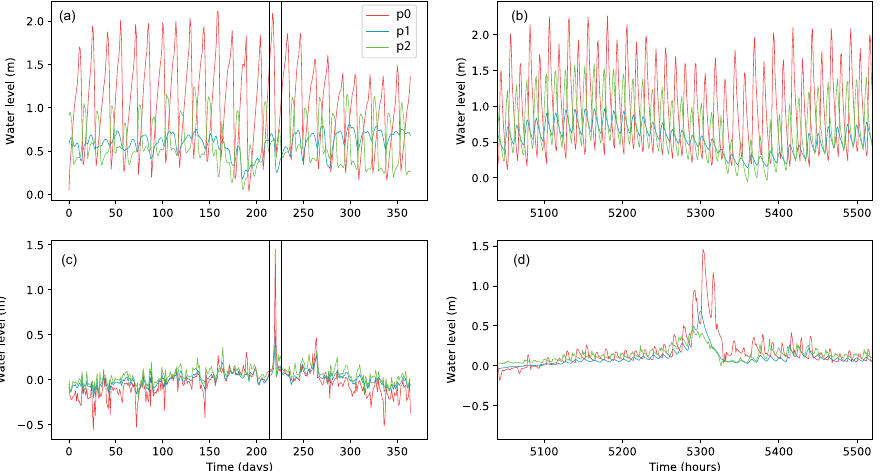
Figure 7. Differences in the river water level at the three coastal unit catchments. ( a , b ) show the difference between S1 and S0 at the daily and hourly scales, respectively. ( c , d ) show the difference between S2 and S1 at the daily and hourly scales,